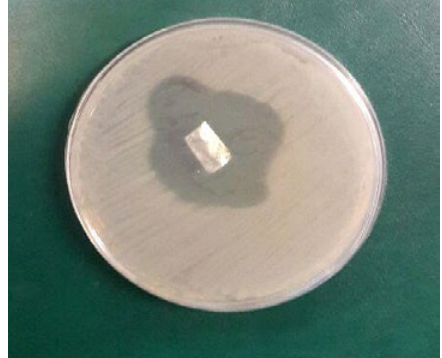
Fig. 4 Antibacterial activity of CS/PEO nanofiber containing vancomycin against S. aureus Fig.5 Antibacterial activity of CS/PEO nanofiber containing vancomycin against E. coli